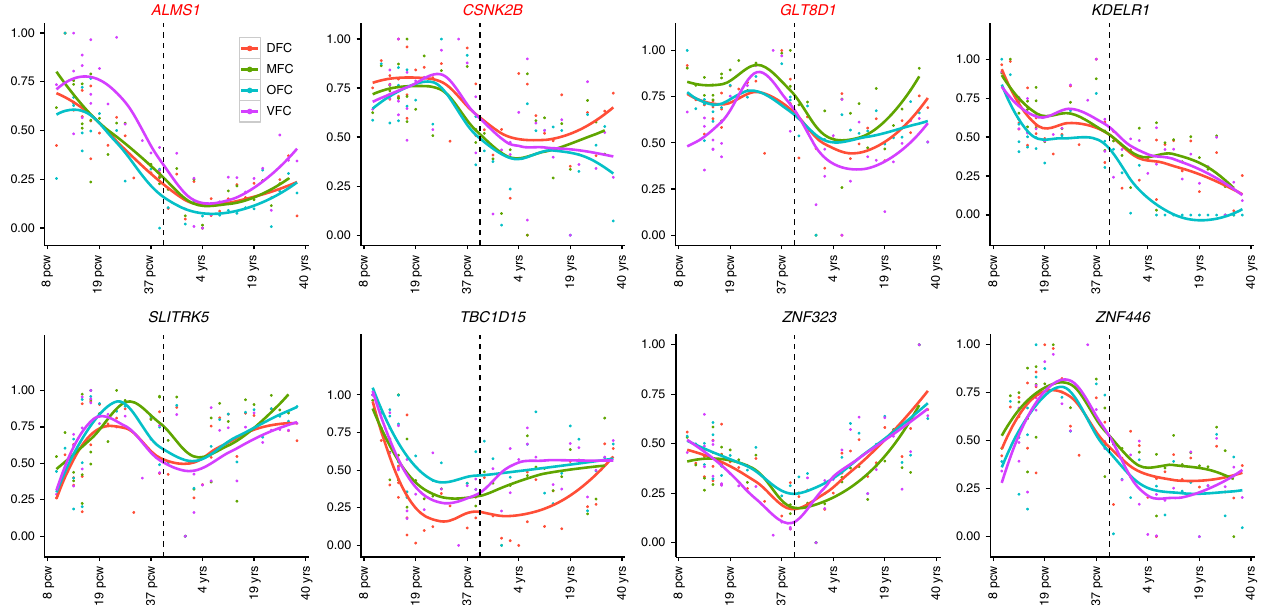
Fig. 1 Expression patterns of the top predicted risk genes (by Sherlock ) in human frontal cortex. Expression level of top predicted risk genes across the entire developing stages (from 8 post-conception weeks (pcw) to 40 years (yrs)) were depicted in the frontal cortex, which was divided into four regions: dorsolateral prefrontal cortex (DFC), medial prefrontal cortex (MFC), orbital prefrontal cortex (OFC), and ventrolateral prefrontal cortex (VFC). Of note, most of the genes showed higher expression level at embryonic and fetal stages (8 pcw to 4 mons) compared with childhood and adulthood stages (8 yrs to 40 yrs), suggesting these genes may have a role in neurodevelopment. The expression data (from frontal cortex of 42 human subjects) were